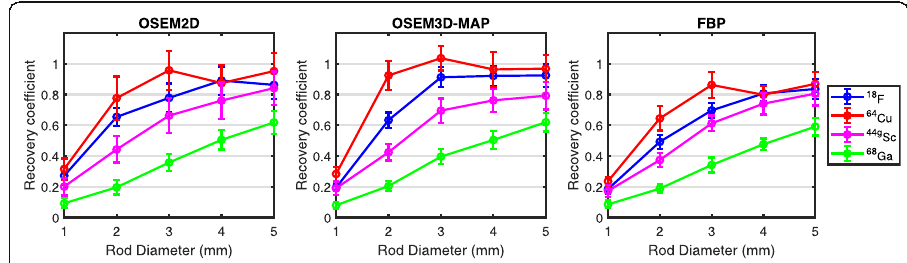
Fig. 4 Impact of radionuclide and reconstruction strategy on measured recovery coefficients